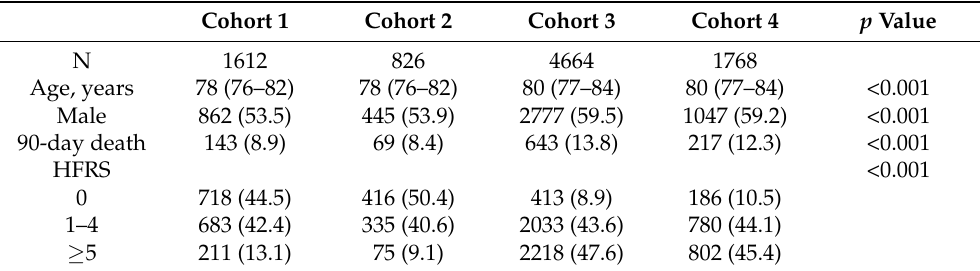
Table 2. Characteristics of the four cohorts.